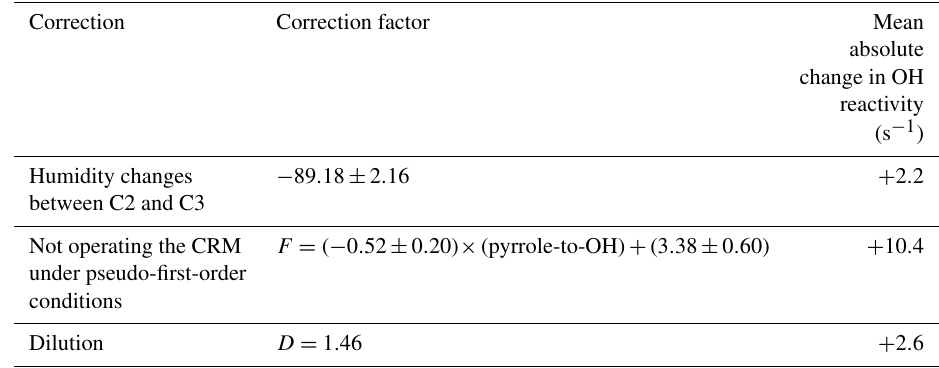
Table 2. Summary of corrections applied to raw reactivity data for LSCE-CRM. Correction coefficients are obtained from experiments performed before, during and after the field